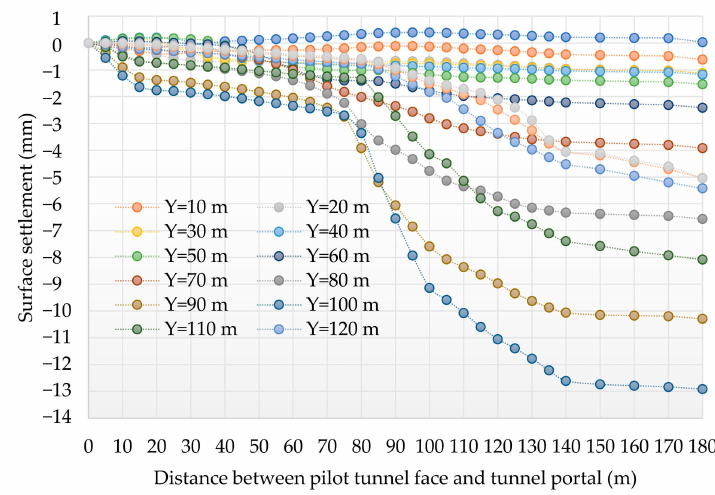
Figure 9. Surface settlement during pilot tunnel